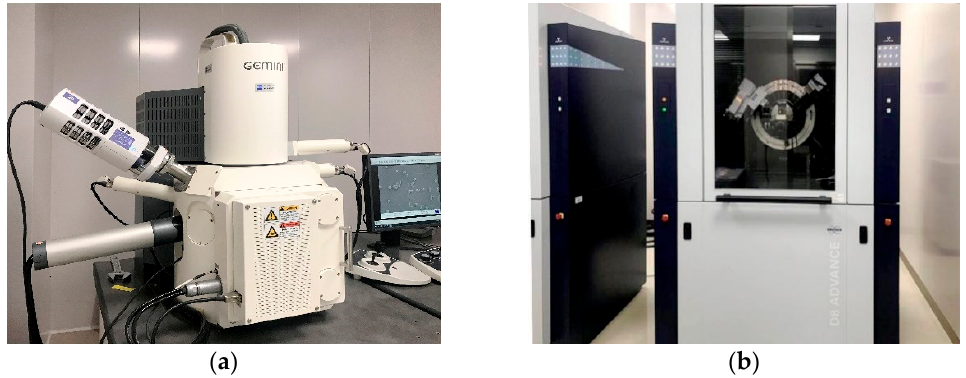
Figure 3. Microstructure test instruments: ( a ) FESEM and ( b ) XRD.